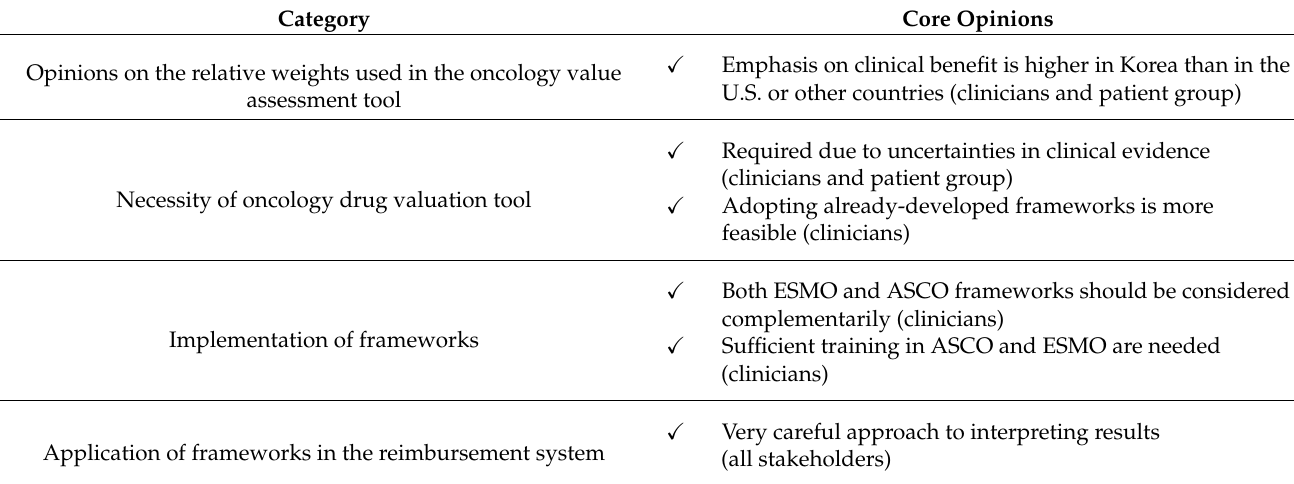
Table 3. Core opinions in focus group interviews